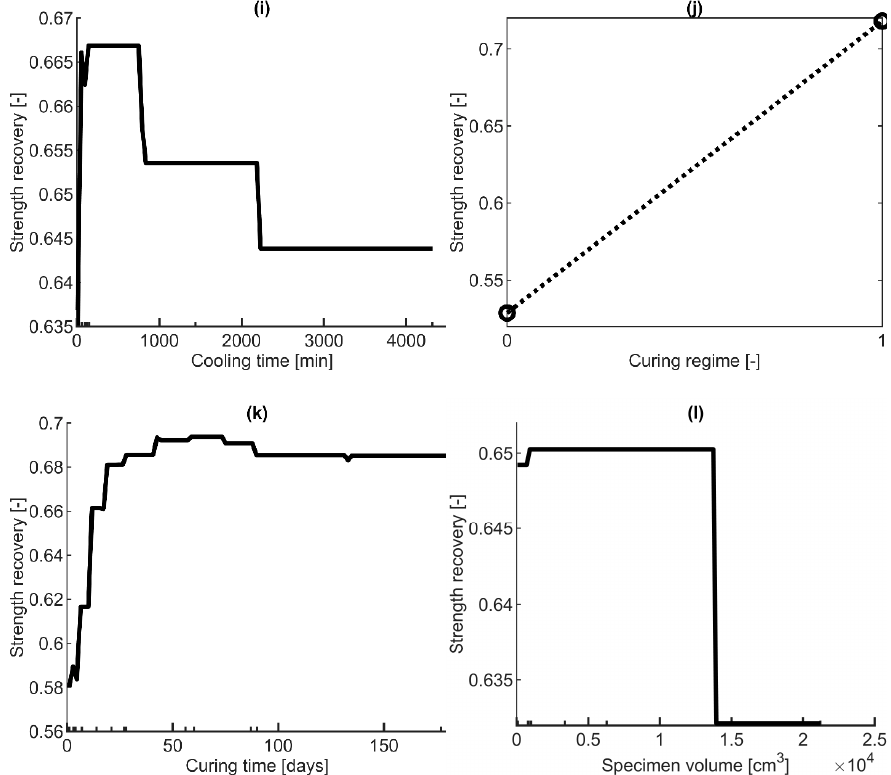
Figure 9. PDPs for each input variable: ( a ) water-to-cement ratio (I1), ( b ) age (I2), ( c ) cement amount (I3), ( d ) fine aggregate (I4), ( e ) coarse aggregate (I5), ( f ) temperature (I6), ( g ) duration of peak temperature (I7), ( h ) cooling regime (I8), ( i ) cooling duration (I9), ( j ) curing regime (I10), ( k ) curing duration (I11), ( l ) specimen volume (I12).